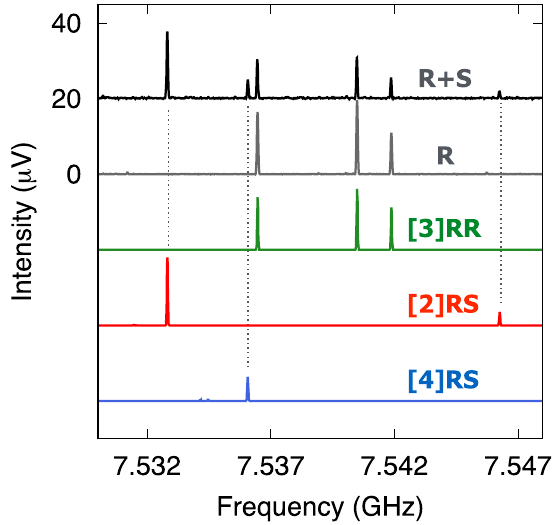
Fig. 3 Rotational spectra for racemic and enantiopure SO. Portion of the broadband spectra for racemic (R + S, black trace) and enantioenriched (R, grey trace) samples. Simulations based on the fi tted spectroscopic parameters of homochiral [3]RR (green) and heterochiral ([2]RS (red), [4] RS (blue)) dimers are plotted below.